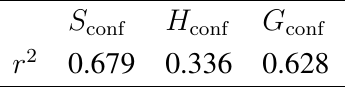
Table 1. Regression coefficients of correlating physical stability above T thermodynamic